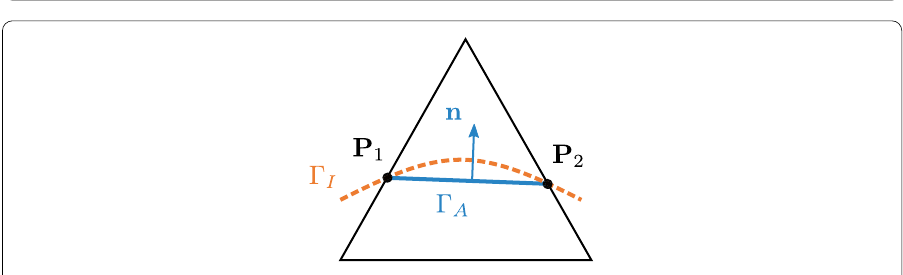
Fig. 11 Test case to evaluate surface approximation for immersed planar geometries. a Test setup: plate immersed into box-shaped background mesh with ∼ 19 , 000 elements. b Reconstruction of the immersed boundary ( (cid:2) A